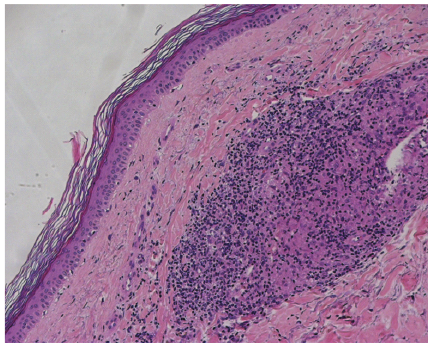
Figure 2: H&E staining, 100x magnification. Epidermis presents rete ridges flattening and orthotopic hyperkeratosis. In the deep dermal layer a sarcoidosis-like granulomatous reaction is visible.